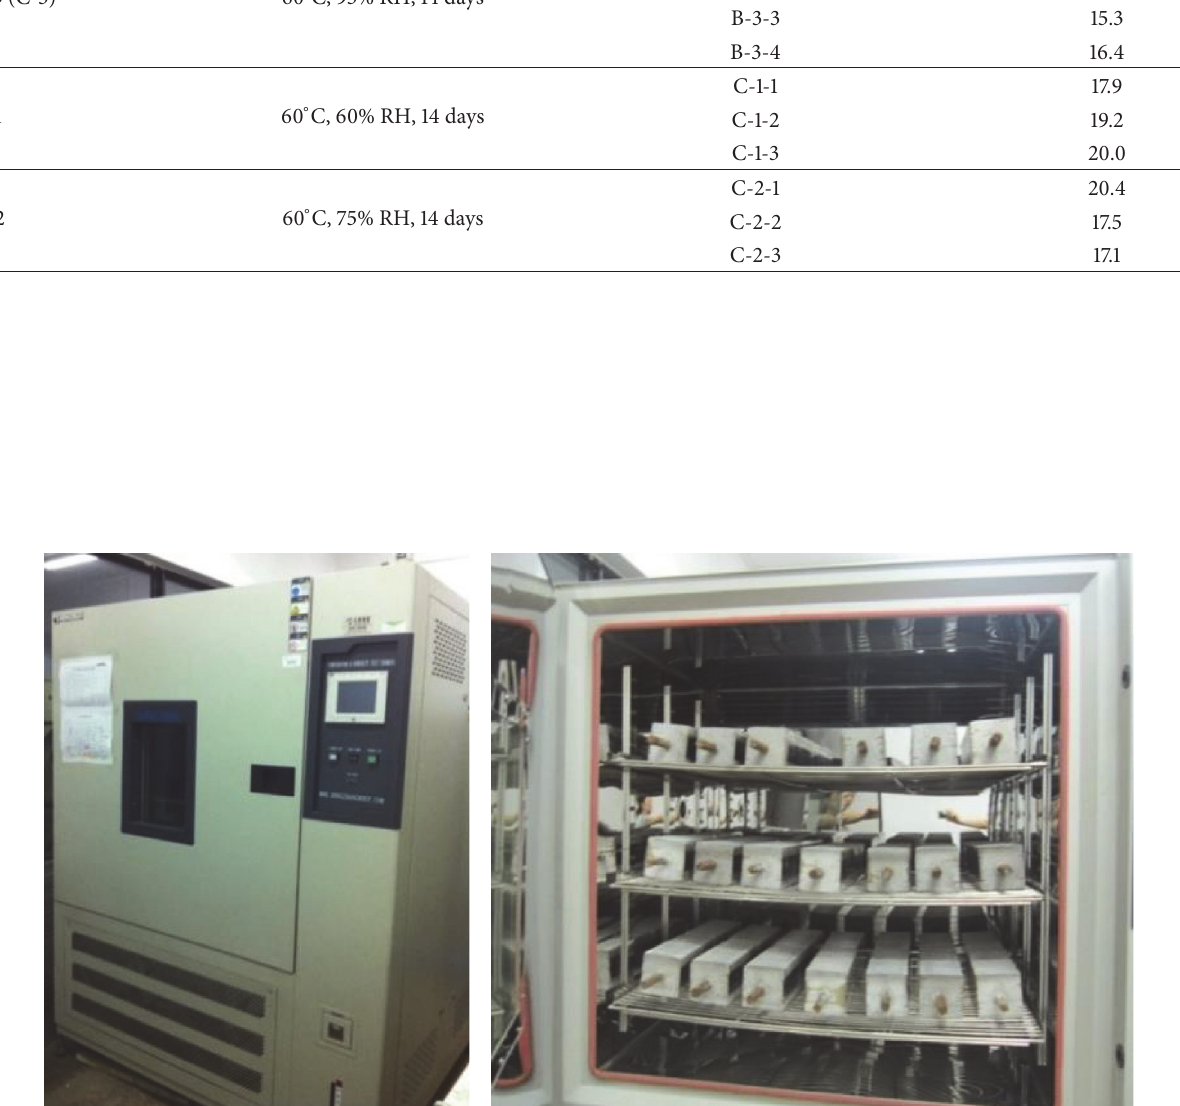
Figure 4: Programmable environmental chamber (HP-800U) and